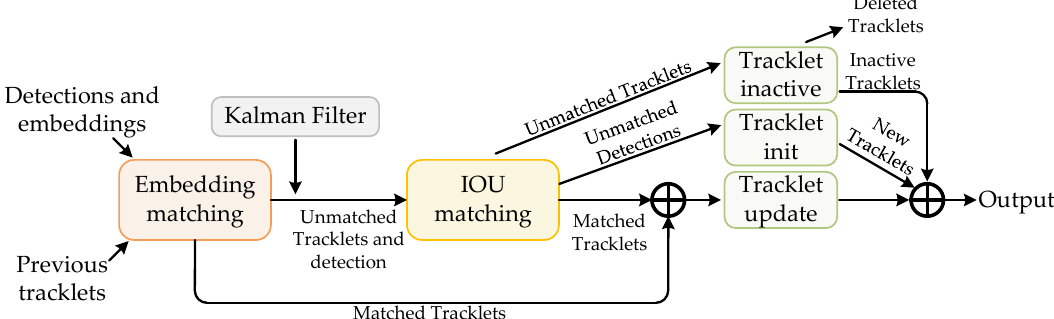
Figure 7. The details of our data association